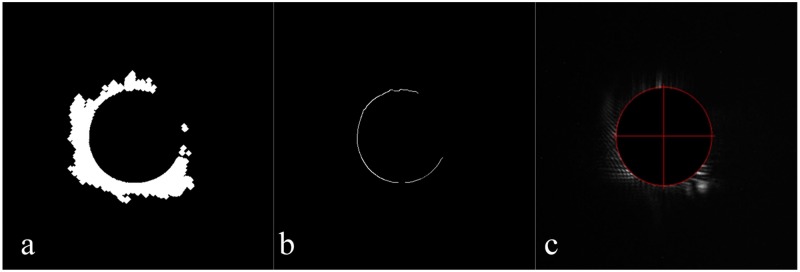
Calculation of the center of the schlieren ball in the side lobe image.(a) The clipped image of the side lobe processed by the morphological operation. (b) The edge of the small ball detected using the Sobel operator. (c) The final center and radius fitted using the circle fitting method.